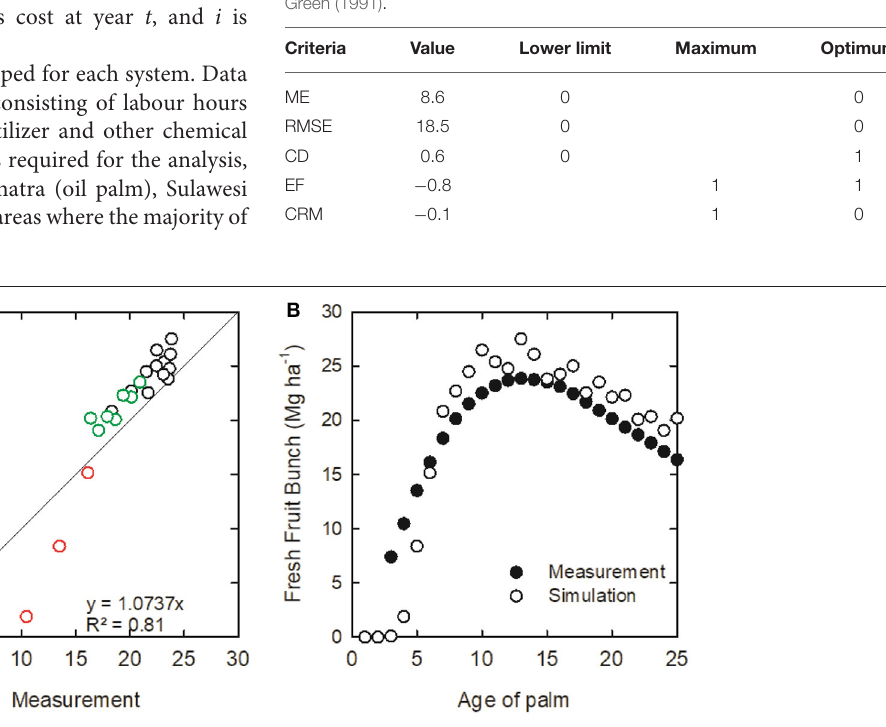
FIGURE 4 | A comparison of simulated and measured fresh fruit bunches of oil palm for a full production cycle (Mg ha − 1 ), (A) direct, (B) as function of palm age. Red and green circle indicated for the early (measured higher than simulated) and late (simulated higher than measured) production stage, respectively.